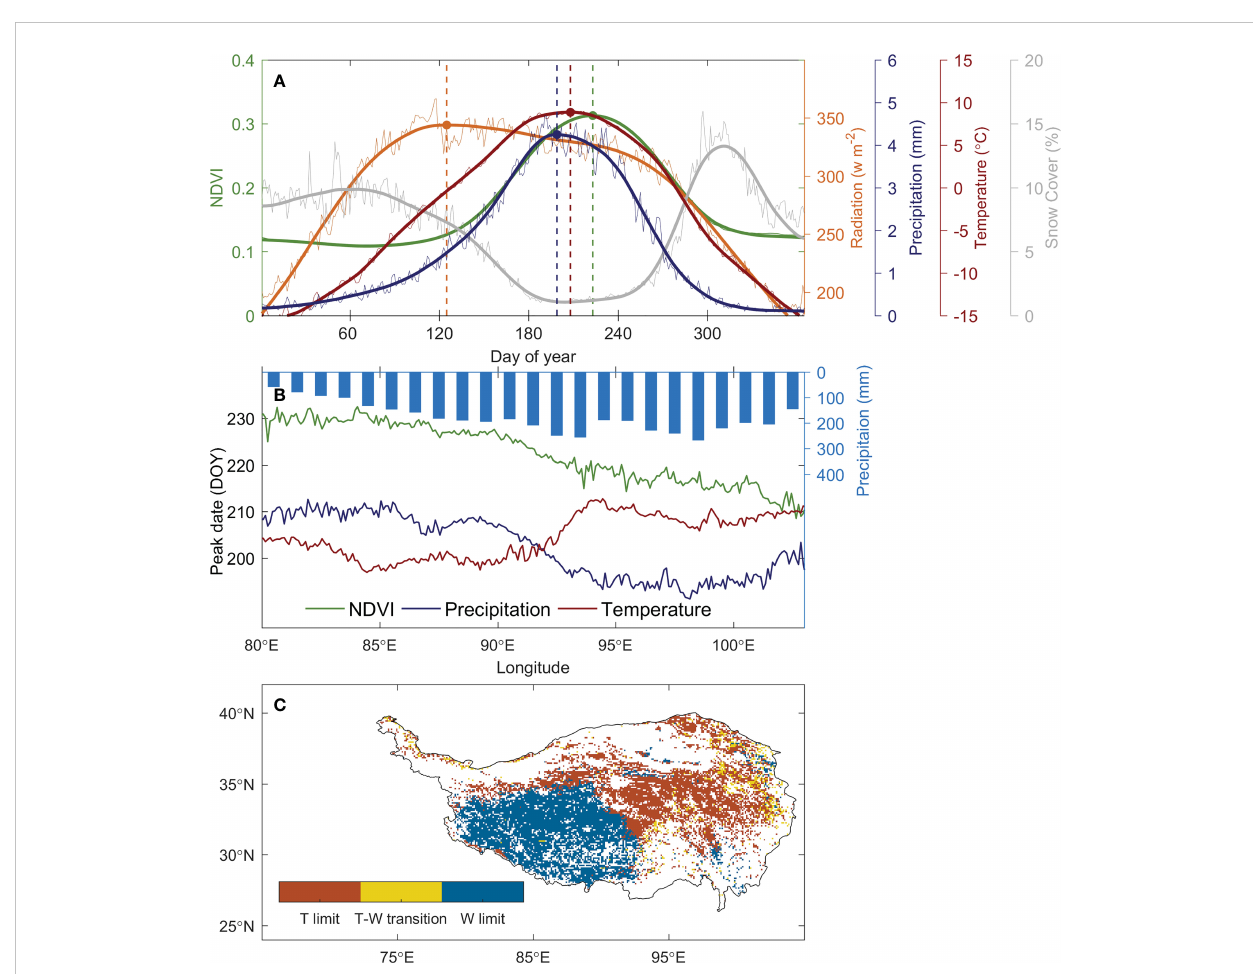
FIGURE 2 The climate constraints for the alpine grasslands over the TP and its spatial distribution. (A) shows the seasonal cycle of solar radiation (orange line), precipitation (blue line), temperature (red line), NDVI (green line), and snow cover (grey line). The dots and vertical dash lines mark the timing of the peaks. (B) illustrates the relative positioning of the timing of temperature (red) and precipitation (blue) peaks against NDVI peaks (green) along the longitude. The blue bars show the precipitation gradient along longitude over the TP. (C) shows the spatial pattern of climate constraints over the TP under the de fi nition in Figure 1 based on the law of minimum.